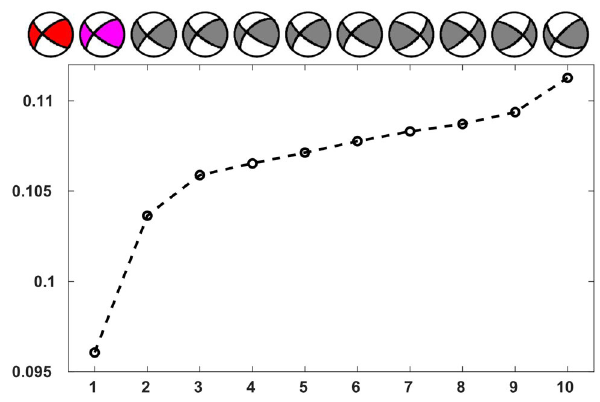
Fig. 5 The comparison of best solutions retrieved in data domain (in red) and feature domain (in magenta). The 10 best solutions (in magenta and black) with the smallest L2-norm mis fi ts retrieved in feature domain are also shown for comparison after ranked in ascending